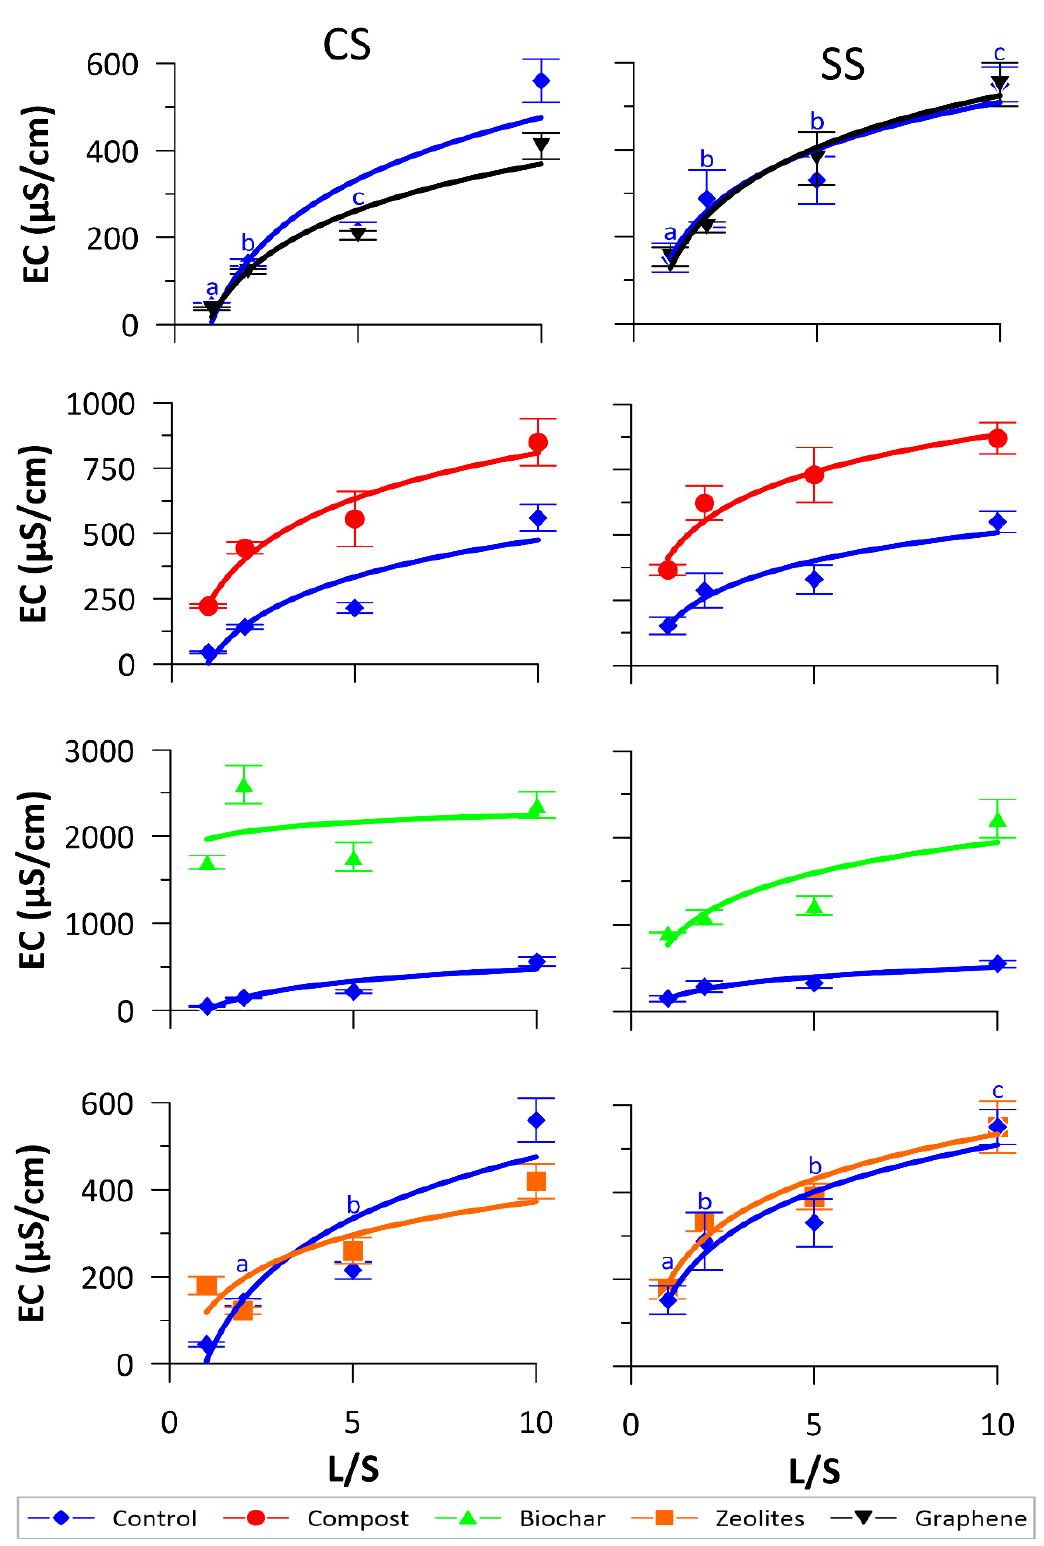
Figure 2. EC values variation in SSE batches with CS ( left panels ) and SS ( right panels ) soils versus L/S ratios at the end of the monitoring period. Error bars denote standard deviation calculated on three replicates, while lines are the best fit natural logarithmic curves. Different letters indicate statistically different means at 0.05 confidence.